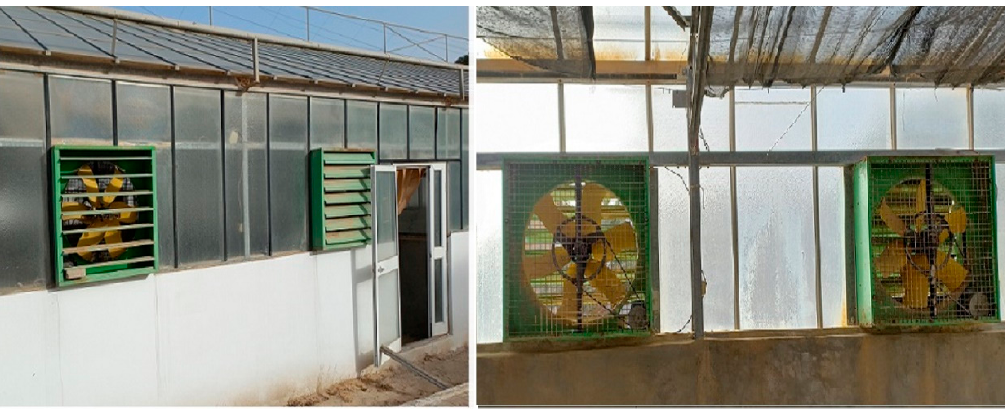
Figure 3. A greenhouse equipped with forced ventilation devices at the Institute of Arid Regions (Kebili, Tunisia).